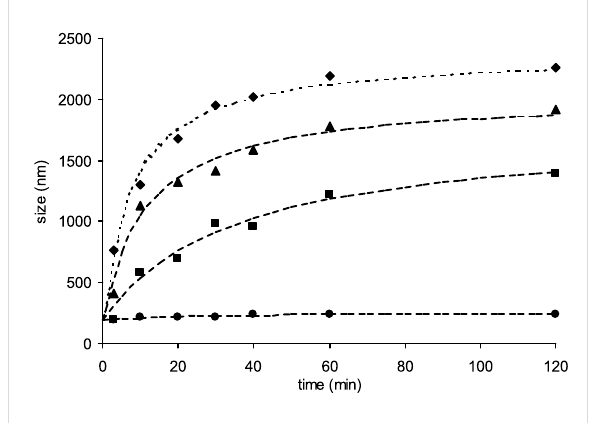
Figure 3: Size of the nanoparticles stabilized with Pluronic ® F-68/NVP- PA-Man (0.8/0.2), after addition of increasing amounts of con A. ● 10 μ L; ■ 50 μ L; ▲ 100 μ L; ♦ 1000 μ L. Measurements realized on supernatant of centrifuged nanoparticles.